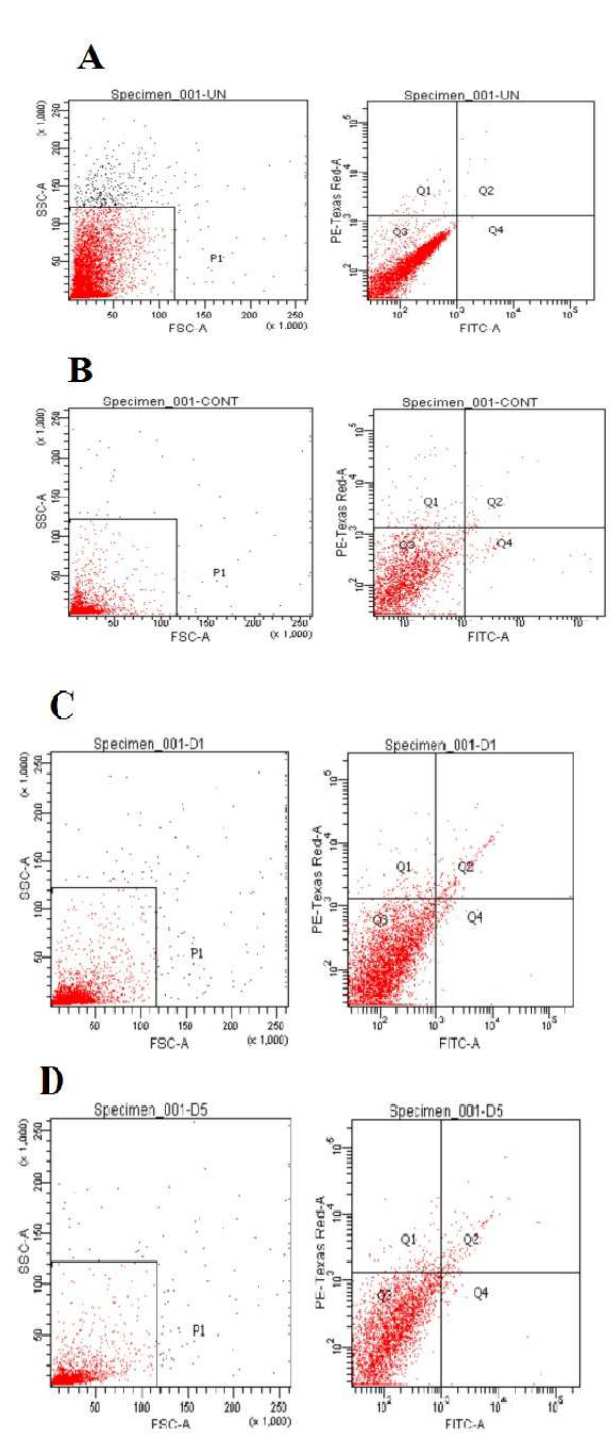
Figure 10. Representative FACS analysis of treated cells ( A ) control cells, ( B ) free drug solution, ( C ) and ( D ) tamoxifen citrate loaded nanolipid vesicles of 50 and 100 μM, respectively, staining with Annexin V/PI.